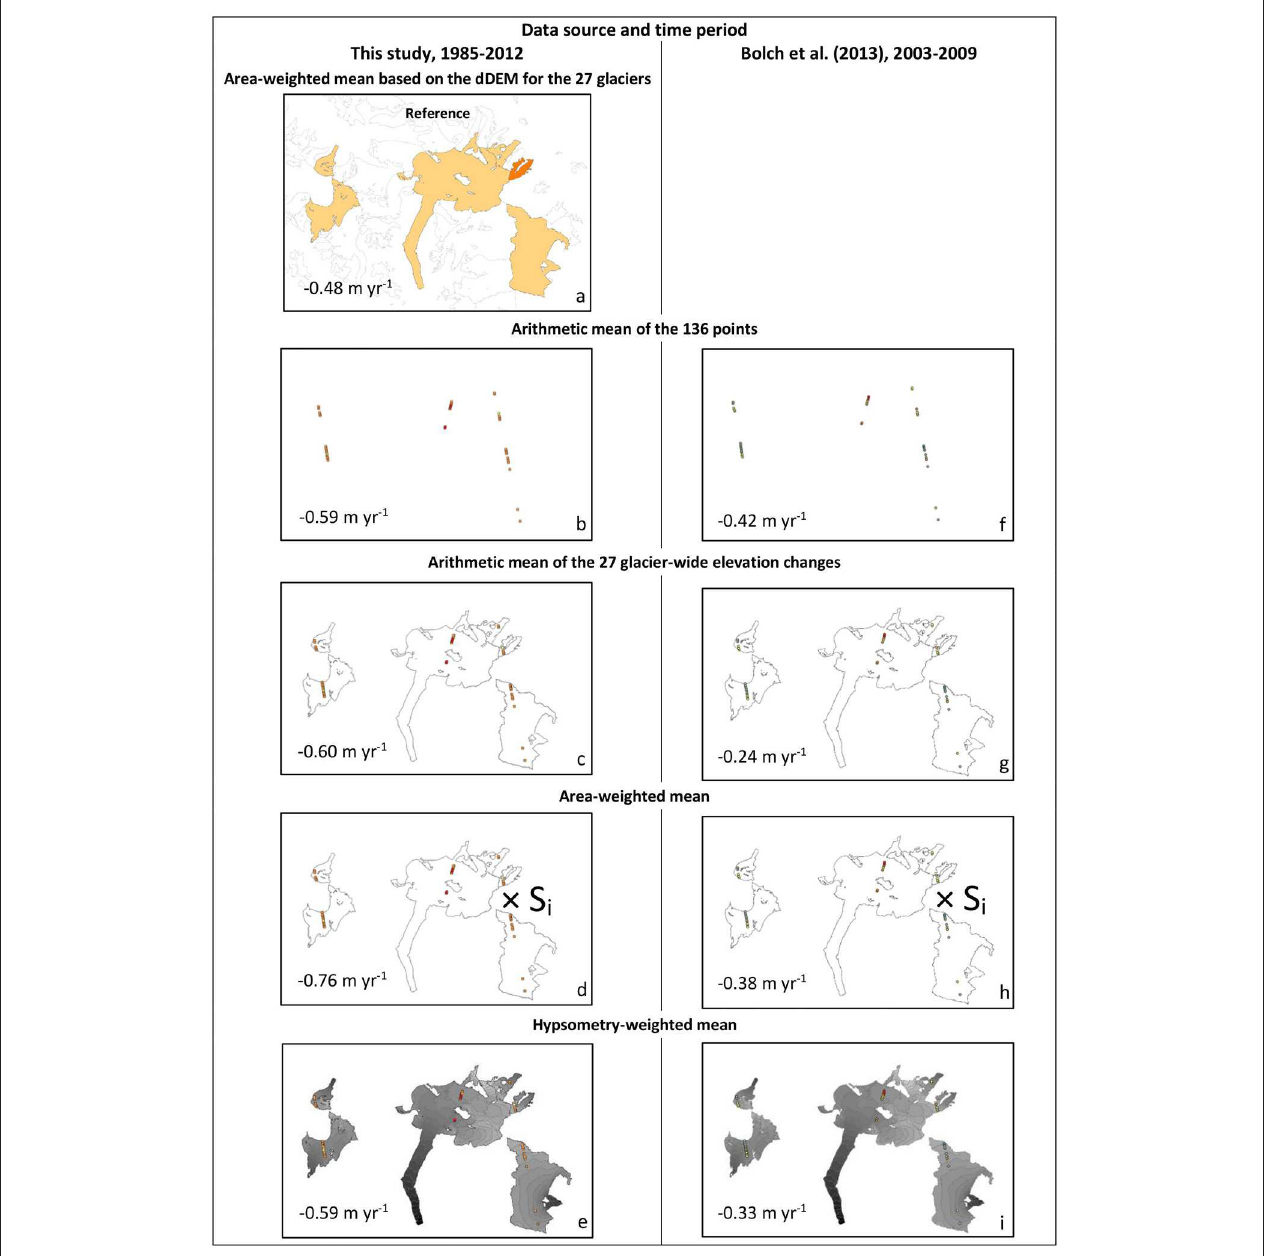
FIGURE 5 | Illustration and corresponding results of the different averaging methods (rows) to calculated the mean elevation change for the 27 glaciers based on (a–e) measurements from this study at 136 ICESat locations and (f–i) 136 ICESat measurements used by Bolch et al. (2013). See text for calculations. Note that the points and squares representing dhdt measurement locations do not represent the actual area of the 70m